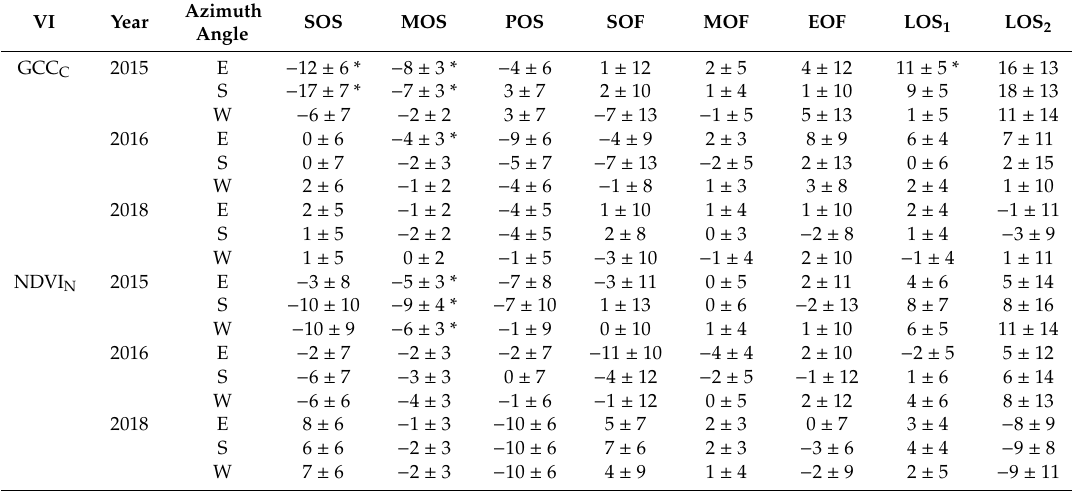
Table 5. Comparisons of the phenophases (number of days, mean ± 95% confidence interval) estimated from east (E), south (S), and west (W) directions with reference to north (N) with an inclination-angle of 30 ◦ in the three measuring